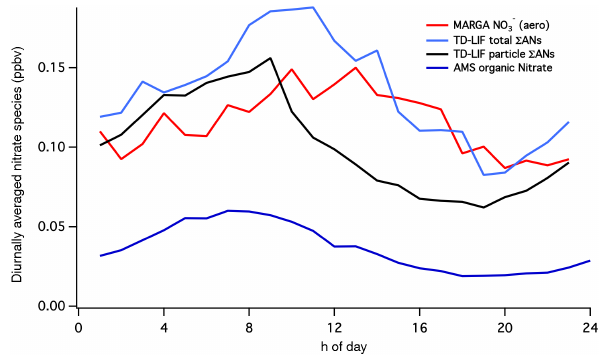
Figure 3. Diurnally averaged organic and inorganic nitrates show organic nitrates peaking in the early morning and inorganic nitrates peaking midday. Note the AMS had a PM 1 size cut, while MARGA and TD-LIF had a PM 2 . 5 size cut. See text and Supplement for more details on this comparison.